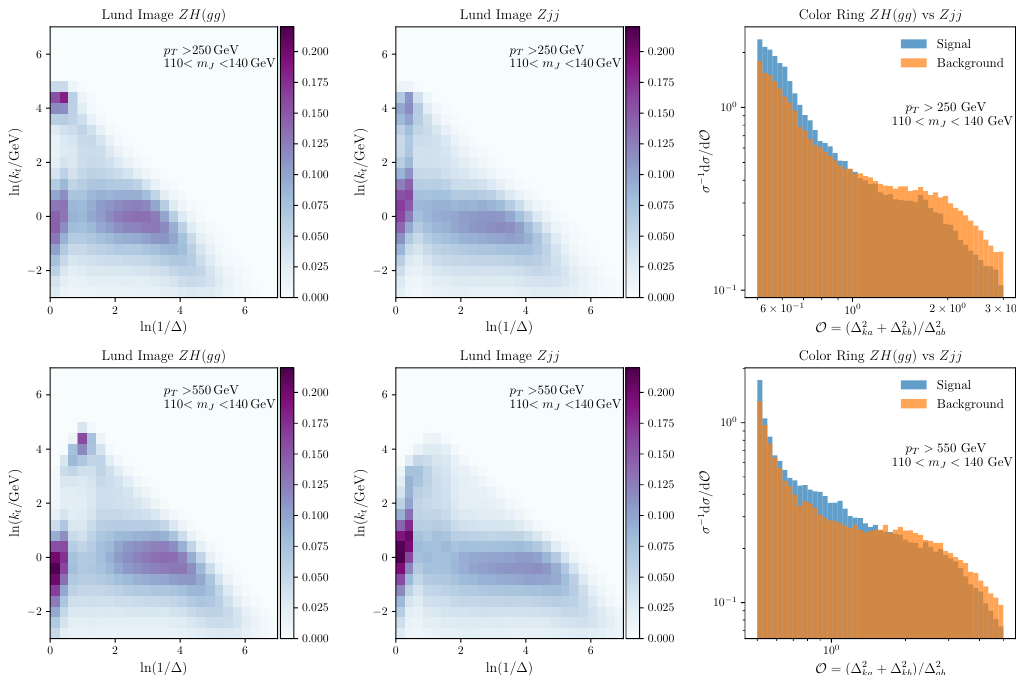
Figure 3: The averaged primary Lund jet plane images and the jet color ring distri- > 250 GeV and p > 550 GeV benchmarks of H → g g analysis. butions for the p T T Figures are taken from Ref [ 3 ]